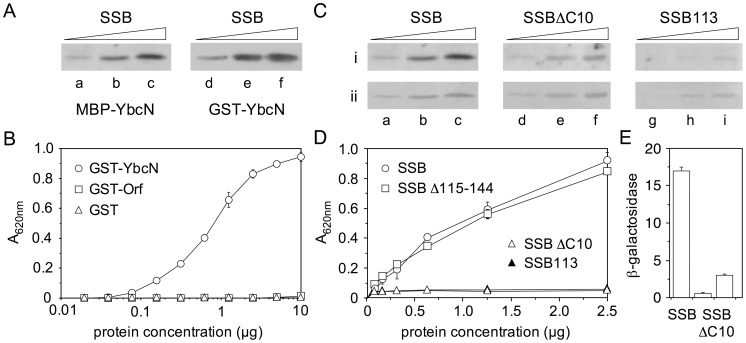
YbcN binding to SSB.(A) Interaction of YbcN with SSB in far western assays. SSB protein (0.5, 1.9, 3.8 µg) separated on 15% SDS-PAGE was blotted and probed with 20 µg MBP-YbcN (lanes a-c) or GST-YbcN (lanes d-f). Interactions were detected with antibodies specific for either the MBP or GST domains. (B) Interaction of GST-YbcN with SSB as detected by ELISA. SSB (0.5 µg) bound to Immulon-1 microtitre plates was exposed either to GST-YbcN, GST-Orf or GST proteins (0.0195-10 µg). Positive interactions were detected by addition of anti-GST antibody-HRP conjugate. Data are the mean and standard deviation of four independent experiments. (C) YbcN binding to SSBΔC10 and SSB113 proteins in far western assays. 0.5, 1.9, 3.8 µg SSB (lanes a-c), SSBΔC10 (lanes d-f) and SSB113 (lanes g-i) separated on 15% SDS-PAGE were blotted and probed with 20 µg MBP-YbcN. Interactions were detected with antibodies specific for MBP (row i). Row ii shows the efficiency of SSB, SSBΔC10 and SSB113 transfer onto blotted membranes as revealed by staining with amido black. Panel i (lanes a-c) is reproduced from (A) to facilitate comparisons with MBP-YbcN binding to wild-type SSB. (D) Interaction of GST-YbcN with SSB, SSBΔC10, SSB113 and SSBΔ115-144 as detected by ELISA. SSB wild-type and mutant proteins (0.5 µg) bound to microtitre plates were exposed to GST-YbcN (0.078-2.5 µg) and probed as in (B). Data are the mean and standard deviation of two independent experiments. (E) Yeast two-hybrid analysis of YbcN interactions with SSB and SSBΔC10. Experiments were performed using constructs fused to the GAL4 DNA-binding or activating domains. The β-galactosidase activities were the mean and standard deviation of three independent experiments. The vertical bars represent the β-galactosidase activity (Miller units) and values for YbcN-SSBΔC10 are given for pGBKT7-53 and pGADT7-T constructs in both orientations.